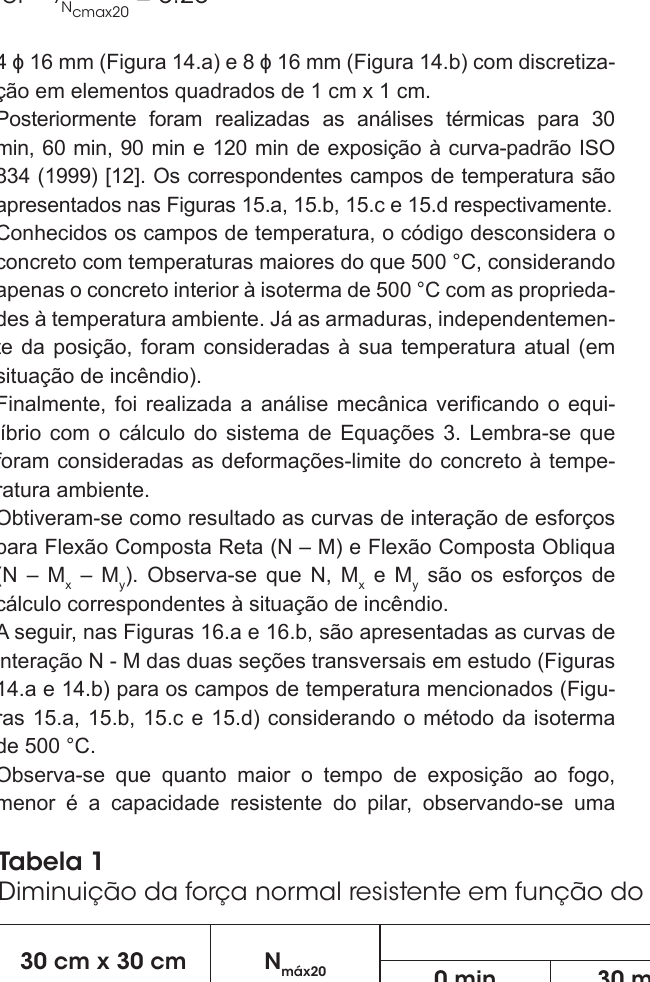
Figura 17d Curvas de interação de momentos da seção 30 cm